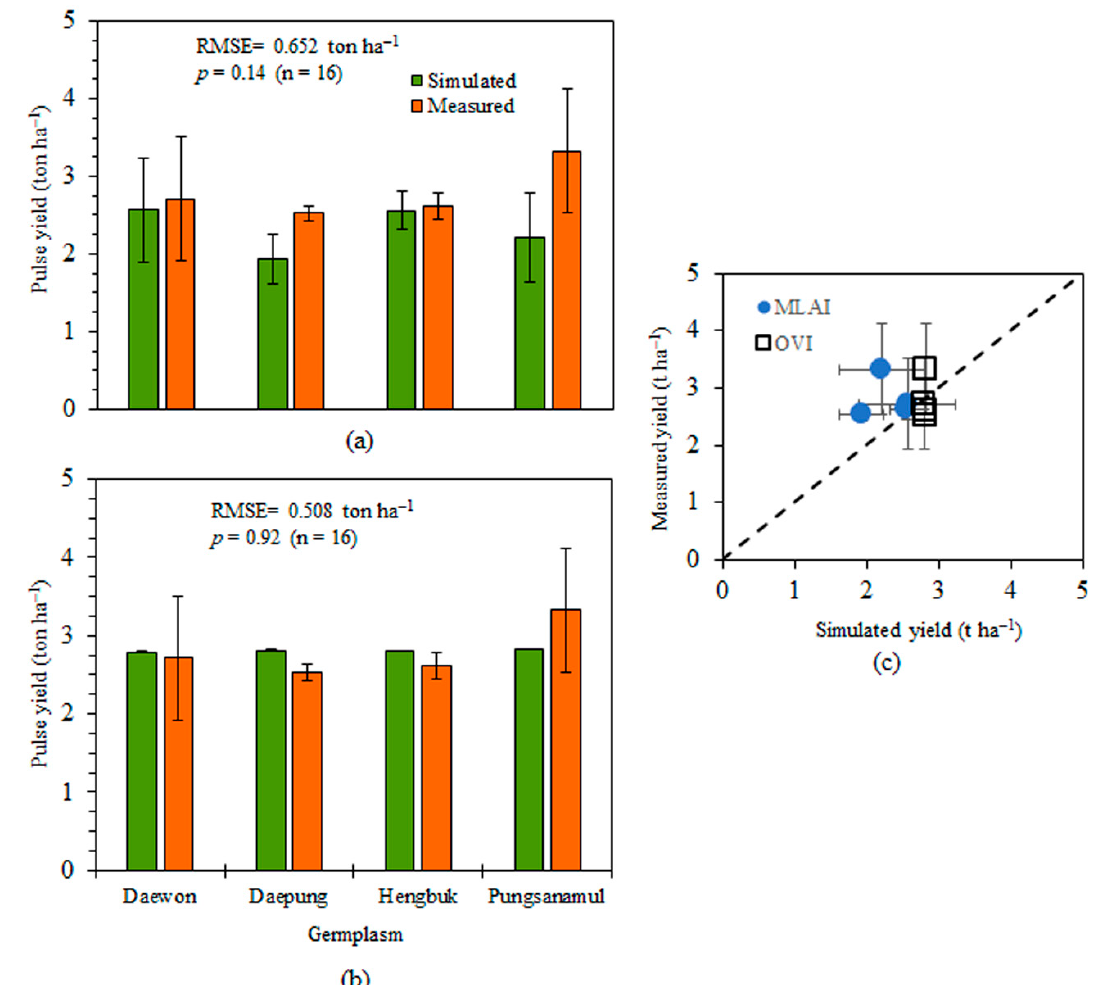
Figure 8. Comparisons between simulated and measured soybean pulse yields using different input options, measured leaf area index (MLAI) ( a ), and observed vegetation indices (OVI) based on proximal sensing ( b ), showing those for both options ( c ) at Chonnam National University, Gwangju, South Korea in 2018. Vertical and horizontal error bars represent ± 1 SE of the mean values. RMSE and p denote root mean square error and the p value according to the two-sample t -test.